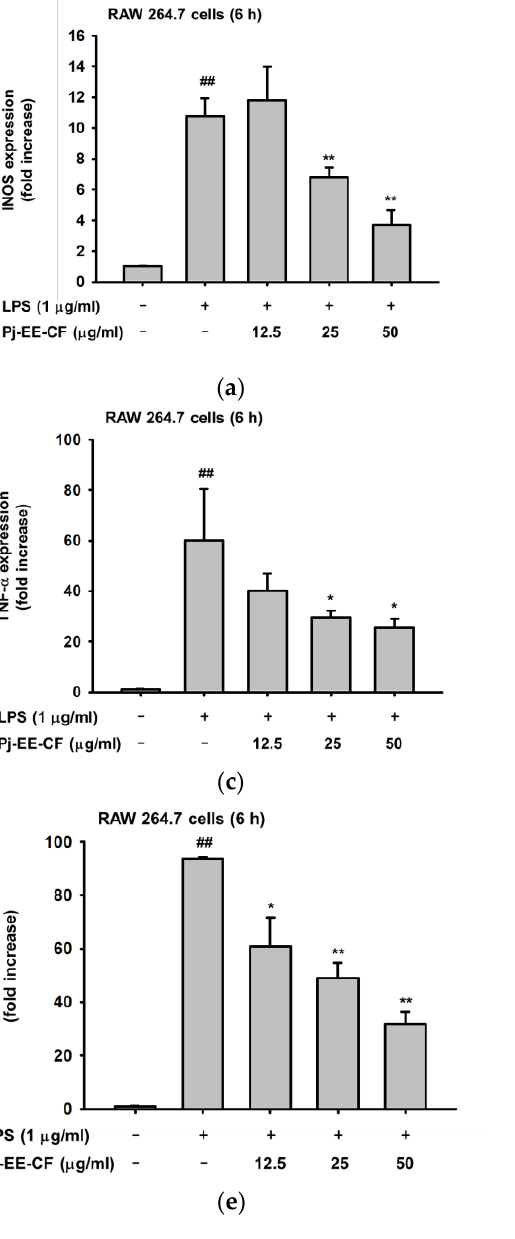
Figure 2. Effect of Pj-EE-CF on the expression of pro-inflammatory genes. The mRNA levels of iNOS ( a ), COX-2 ( b ), TNF-α ( c ), IL-1β ( d ), IL-6 ( e ), and IL-10 ( f ) were evaluated by qPCR on LPS-stimulated RAW264.7 cells. Results are expressed as mean ± standard deviation. ## p < 0.01 compared to normal group, and * p < 0.05 and ** p < 0.01 compared to control group (LPS alone). The p value was calculated using Bio-Rad CFX software.